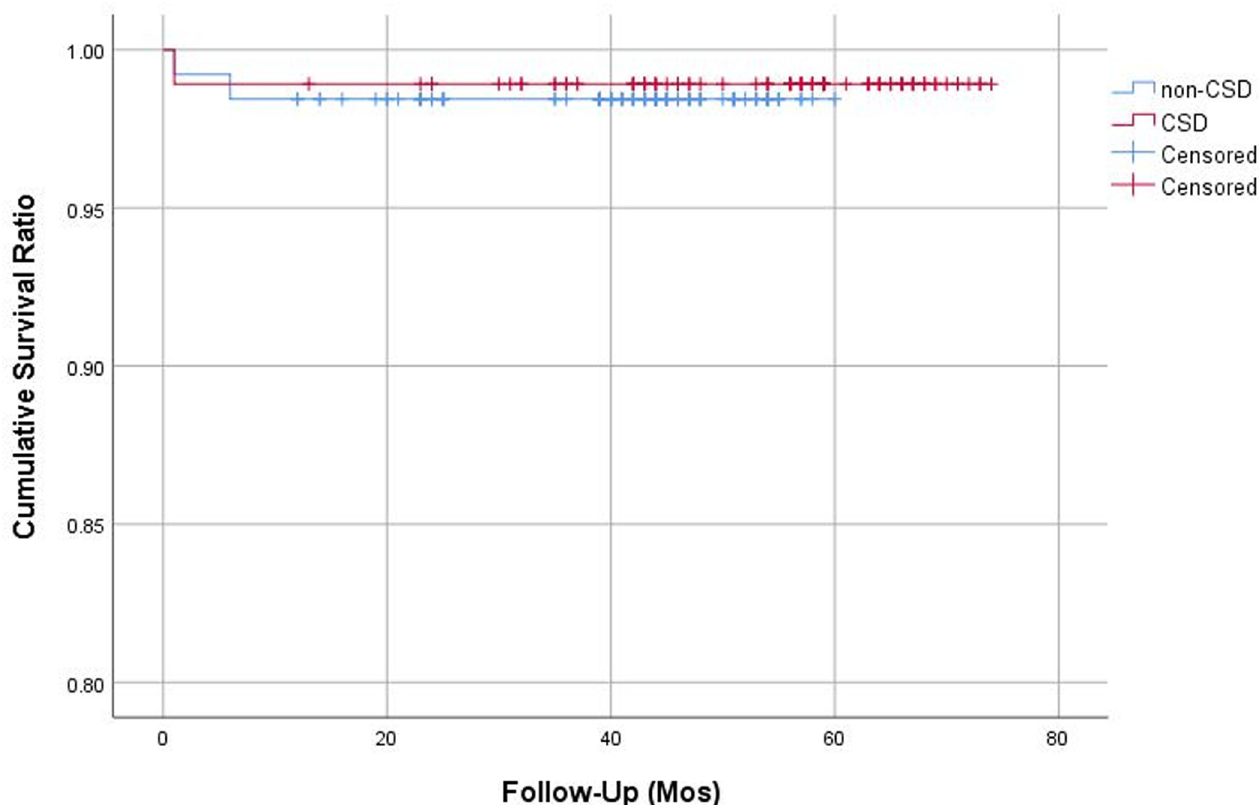
Fig 2. Kaplan-Meier survival curves with ends points of revision for any reason. CSD, closed suction drainage.